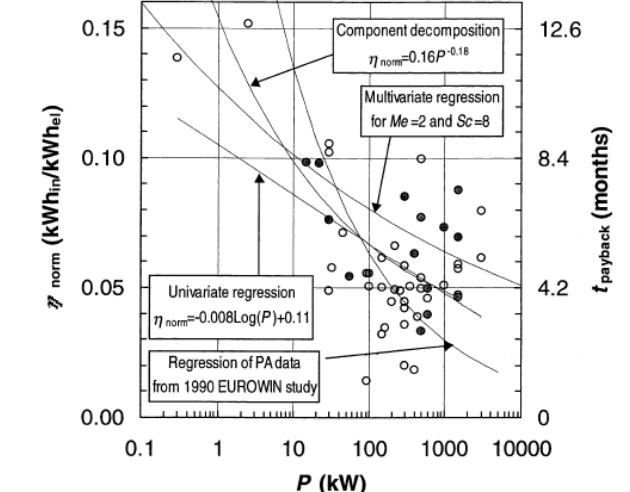
Figure 50. Cumulative energy requirements of wind energy converters as a function of rated power. The multivariate regression line takes into account different scopes and methodologies adopted in case studies. A ratio of thermal energy input to electricity output /kWh is found to be realistic for modern large turbines. © 2002 Elsevier, of 0.05 kWh th el reproduced with permission from